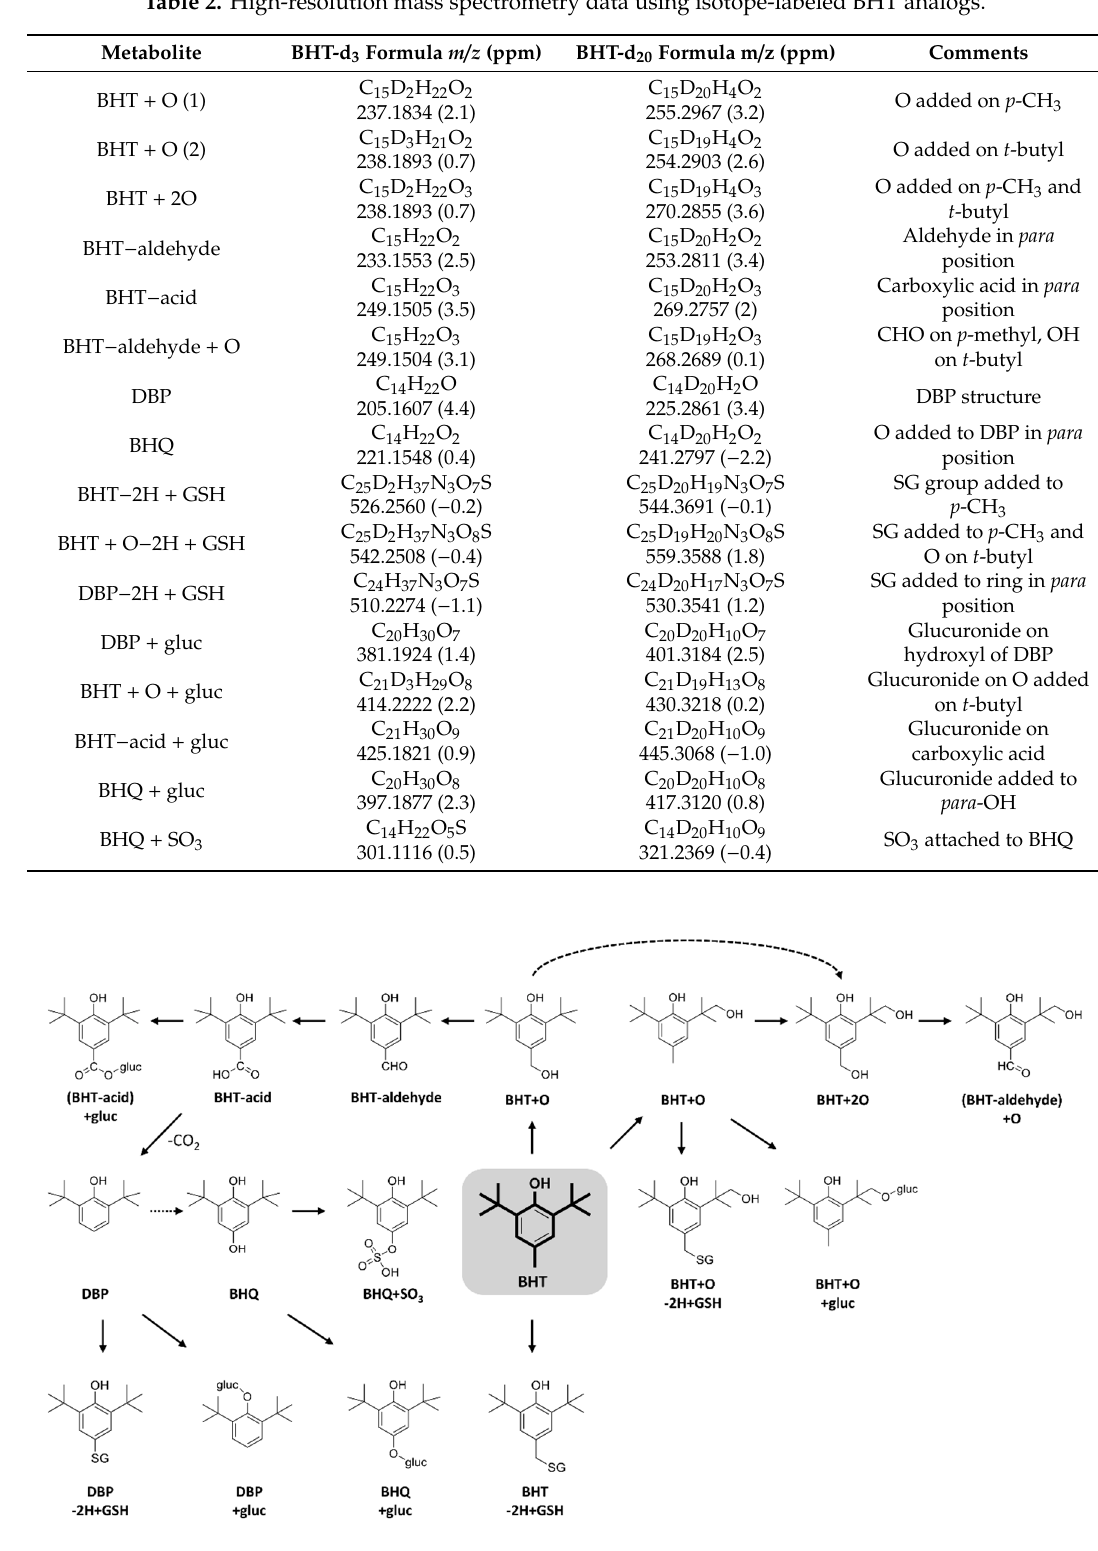
Figure 3. Proposed biotransformation reactions of BHT.